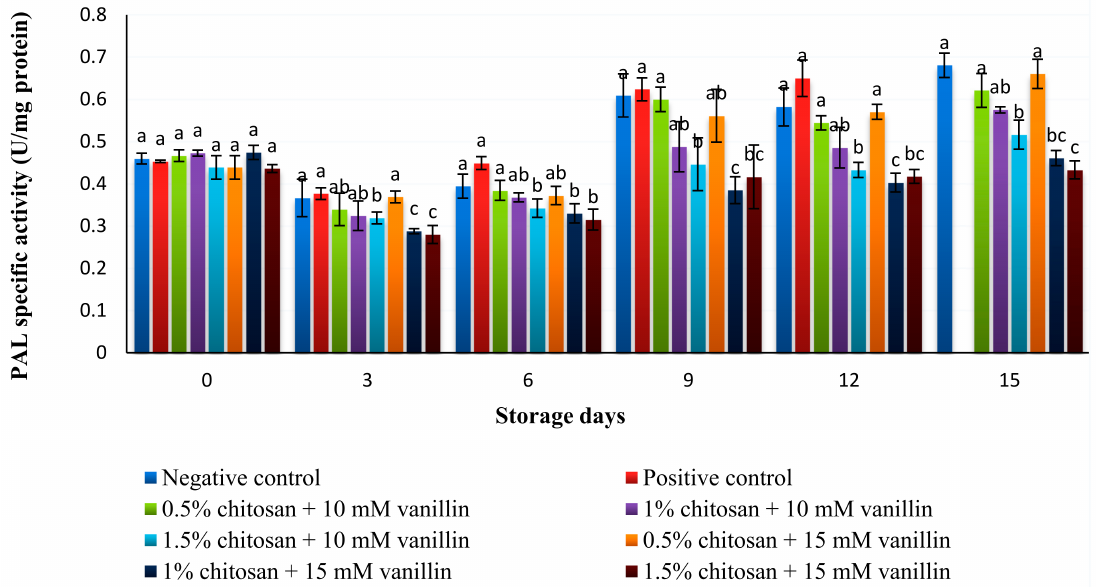
Figure 8. Effects of coating treatment on PAL specific activity in Fusarium oxysporum inoculated tomato fruit stored for 15 days at 26 ± 2 ◦ C and 60 ± 5% relative humidity. Mean values in a column followed by different letters for each storage day differed significantly by LSD at p ≤ 0.05. Vertical bars indicate standard error of means ( n = 24).